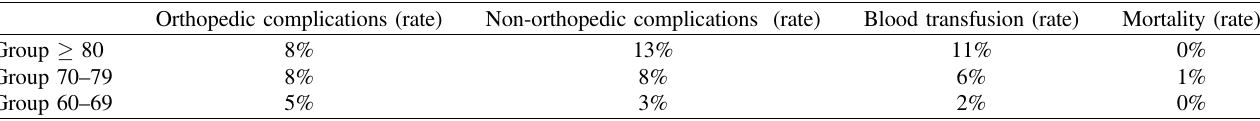
Table 12. Rates of orthopedic complications, non-orthopedic complications, blood transfusion, and mortality. Orthopedic complications (rate) Non-orthopedic complications